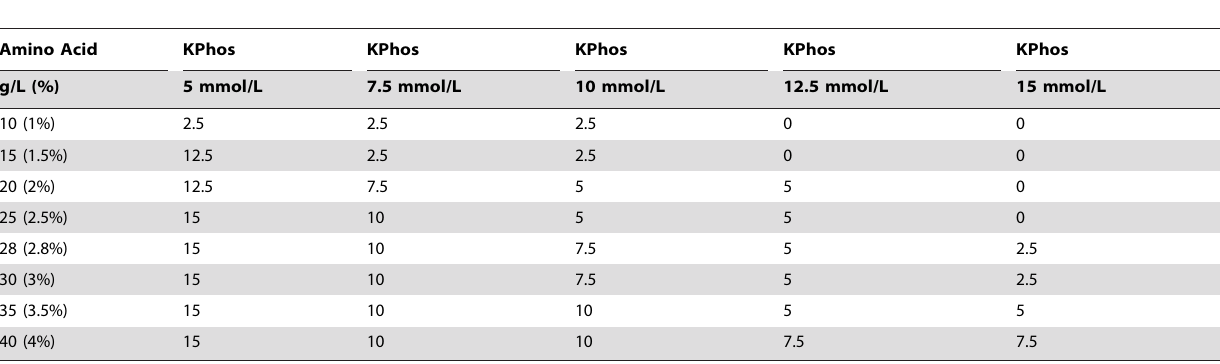
Table 3. Maximum Concentrations (mmol/L) a of Elemental Calcium (as CaCl 2 ) Allowable Without Precipitation at Various Trophamine and Potassium Phosphate Concentrations.